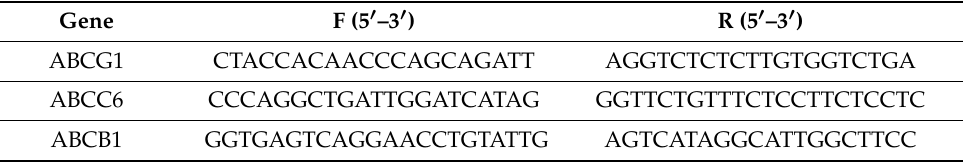
Table 1. List of primers for PCR amplification of drug resistance genes.